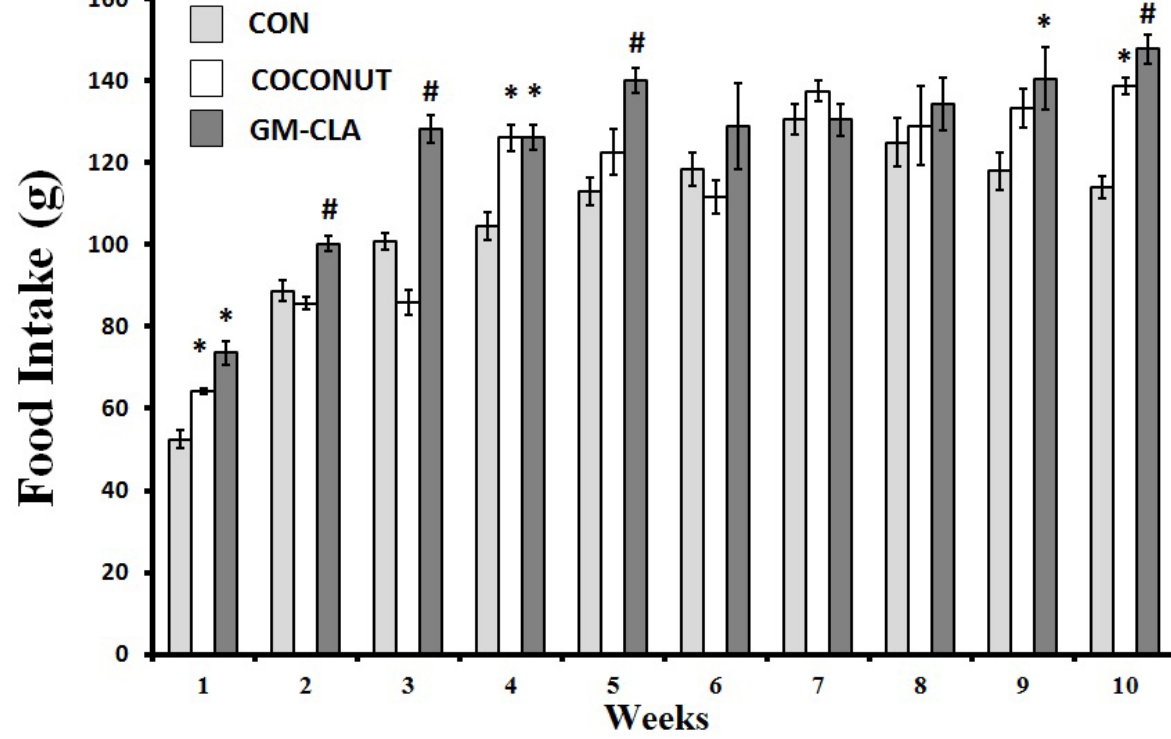
Figure 2. Weekly means of food intake for each experimental group. The number of animals in the groups is 12. An (*) denotes a significant difference ( p ≤ 0.05) from control group. An ( # ) denotes a significant difference ( p ≤ 0.05) from control and coconut